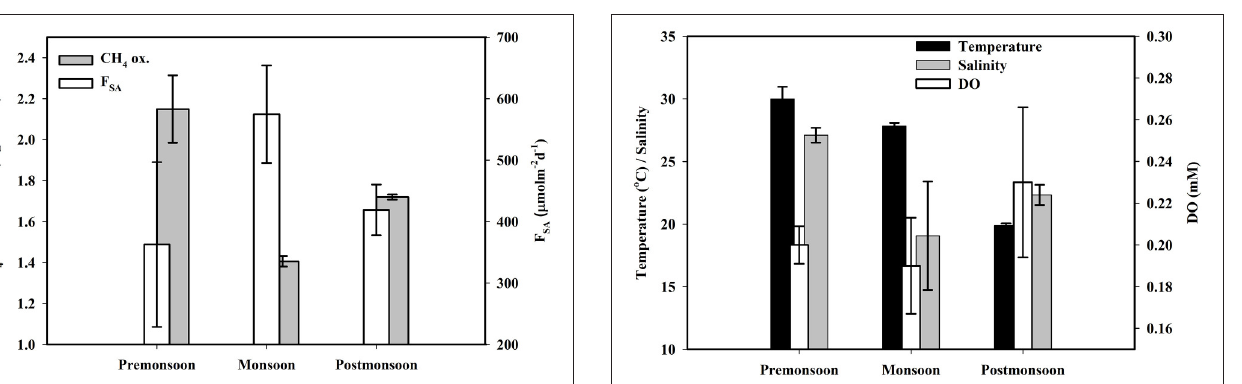
FIGURE 8 | Seasonal variations of estuarine surface water temperature, salinity, and DO conc.